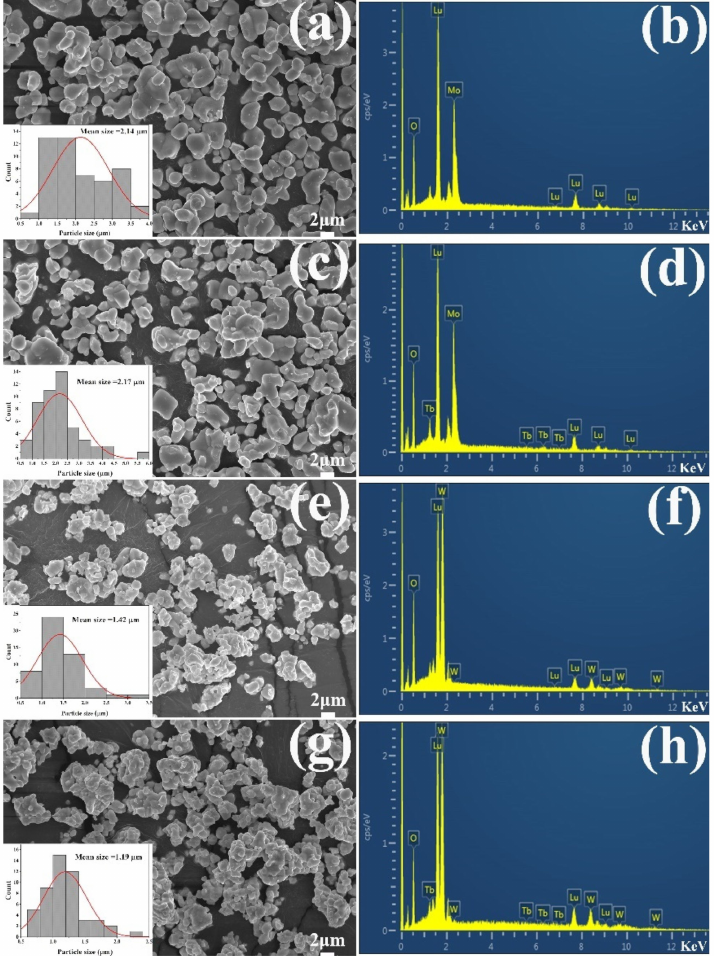
Figure 5. FE-SEM images and EDS spectra of undoped Lu 2 Mo 3 O 12 ( a , b ), 5 mol% Tb 3+ -doped Lu 2 Mo 3 O 12 ( c , d ), undoped Lu 2 W 3 O 12 ( e , f ), and 5 mol% Tb 3+ -doped Lu 2 W 3 O 12 ( g , h ) prepared at 1000 ◦ C. Insets in FE-SEM images are corresponding particle size distribution